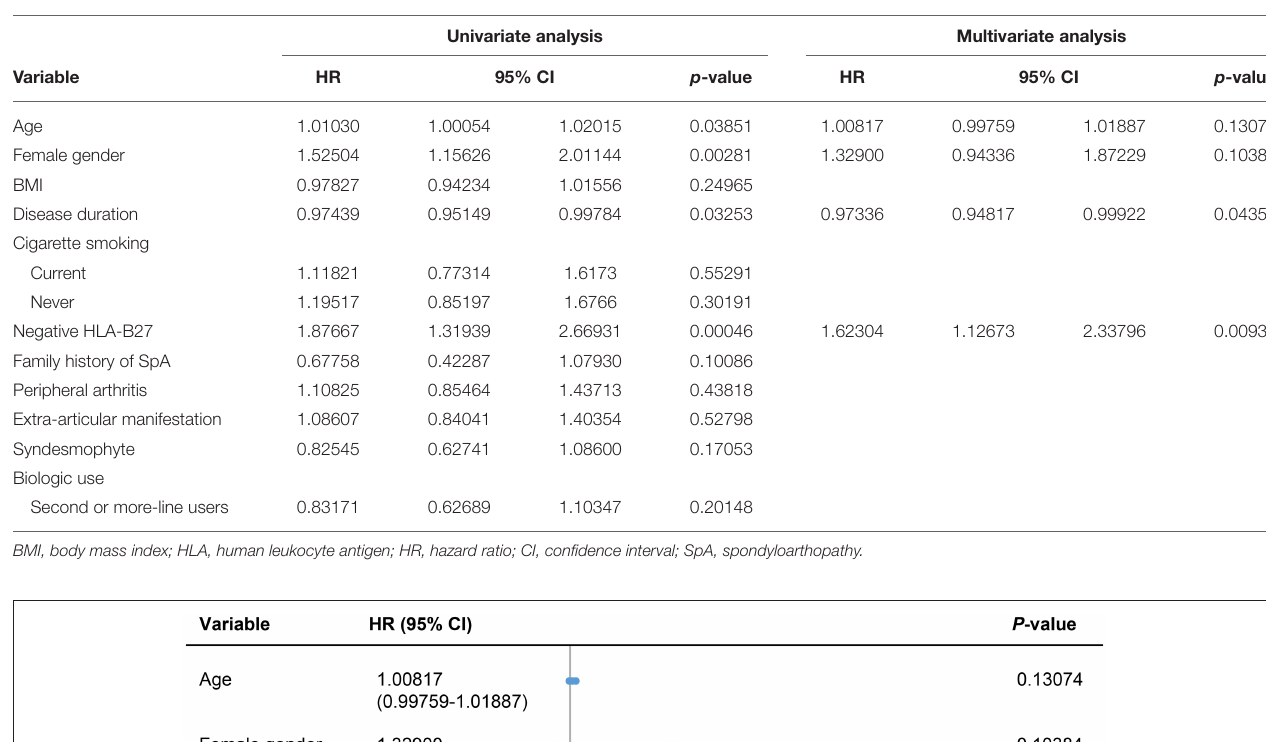
TABLE 4 | Predictors of discontinuation of tumor necrosis factor inhibitors.